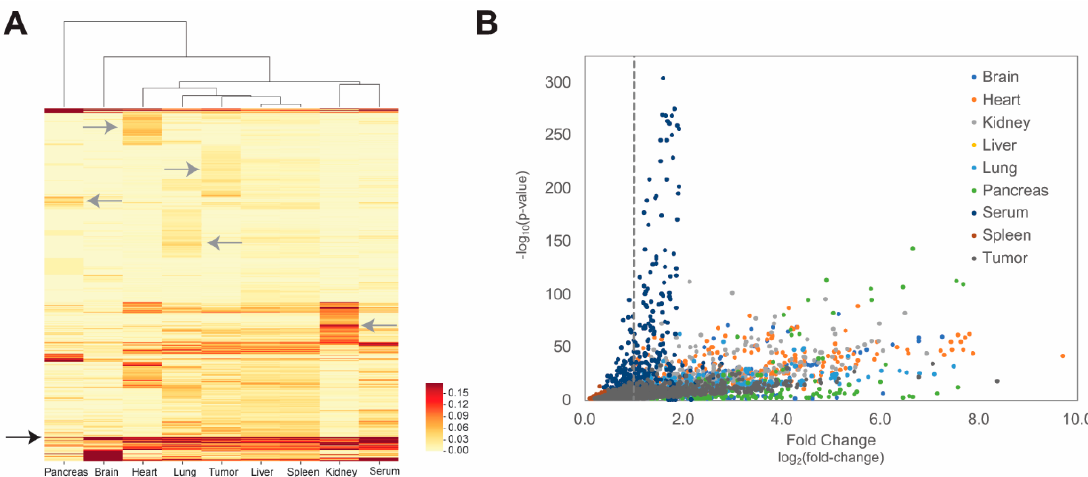
Figure 5. Identification of tissue-selective motifs by tissue. Tissue-selective motifs were visualized via ( A ) hierarchically clustered heatmap of motif occurrence within each tissue and ( B ) one-sided volcano plot visualizing motifs that were significantly increased in copy number as compared with the unselected f8 / 9 phage library within each tissue. ( A ) Tissue-normalized motif counts, expressed as a percentage of each recovered population from each tissue, were generated for each motif, and clustered based on similar motif frequency patterns across the tissues studied. Motif percentages were visualized in a heatmap with yellow bands representing low frequency motifs and red bands representing high frequency motifs. Nonspecific tissue motif clusters are indicated by black arrows and tissue-specific motif clusters are indicated by grey arrows. ( B ) Tissue-selective motifs were identified by plotting the log 2 (fold change) of tissue-specific motif occurrence as compared with library-normalized motif frequencies against the log 2 (p-value) as calculated by a Fisher’s exact test. A threshold of p ≤ 0.05 and 2-fold changes in motif occurrence (represented by the dashed, grey vertical line) were used to identify significantly accumulated motifs within each tissue.